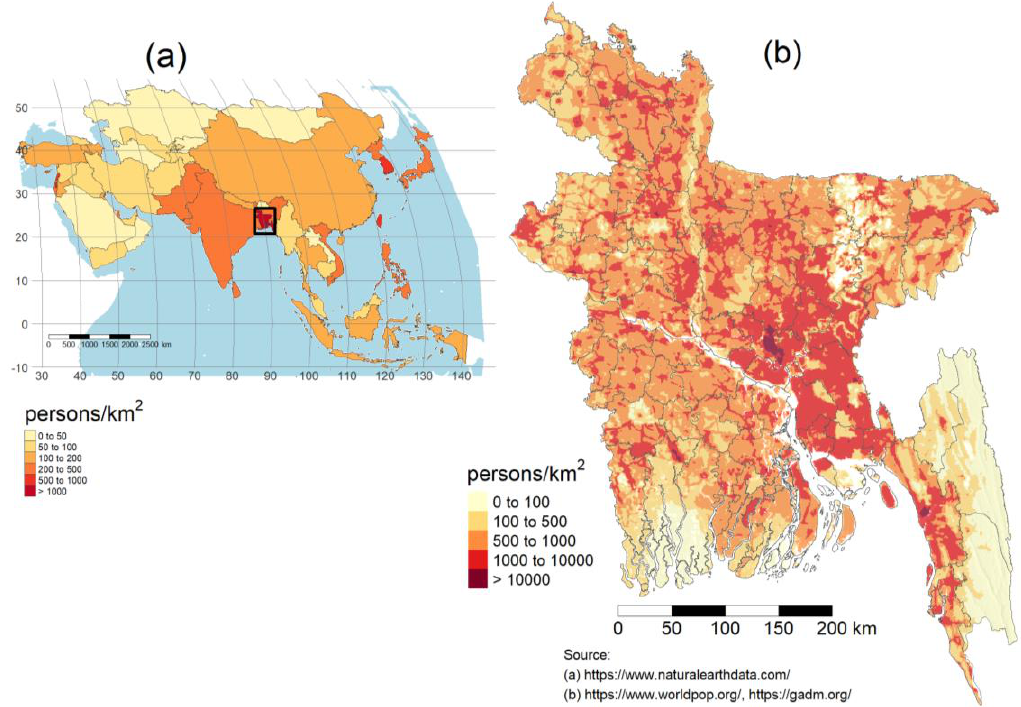
Figure 1. Study area map: Population density in Asia and Bangladesh. ( a ) Population in persons / km 2 in Asian countries. ( b ) Population in persons / km 2 in Bangladesh. Bangladesh is among the most densely populated countries in the world and as population density increases, so does the demand for food staples like rice. Boro season rice production helps meet the growing demand for food, and typically improves the efficiency of rice production with higher yields per unit of area. As arable land decreases due to urbanization and other factors, understanding where rice is grown will be increasingly important.